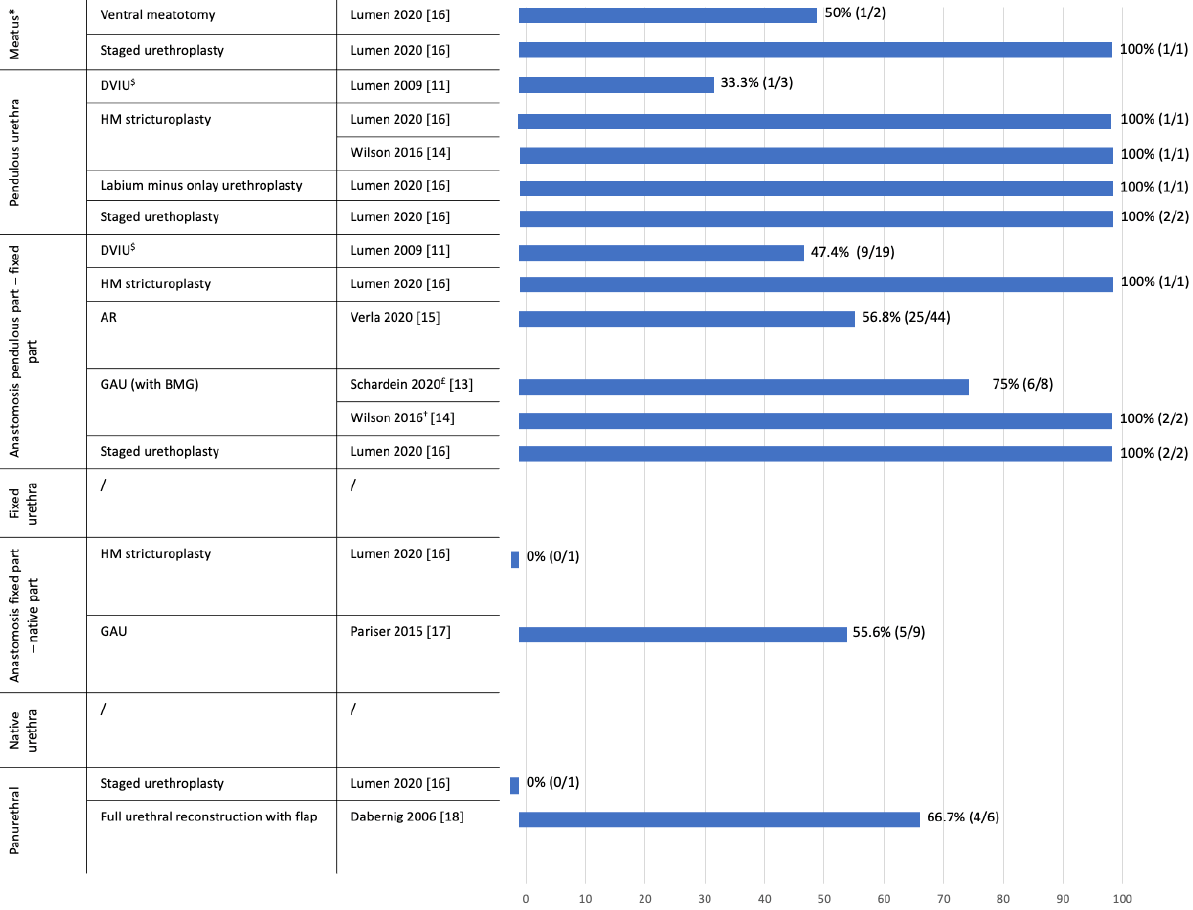
Figure 2. Percentage of urethral patency per type of urethral repair stratified by location. Lumen et al. [12] was not taken into account in this figure, since no clear patency rates per location and per type of urethroplasty could be withdrawn from this study. * Wilson 2016, no information on treatment and follow-up of one meatal stricture, $ only first DVIU included, £ (1 patient no information on follow-up, not included in recurrence rate), † all with fasciocutaneous flap reinforcement. DVIU (Direct Vision Internal Urethrotomy), HM (Heineke Miculicz), AR (Anastomotic Repair), GAU (Graft Augmented Urethroplasty), BMG (Buccal Mucosal Graft).